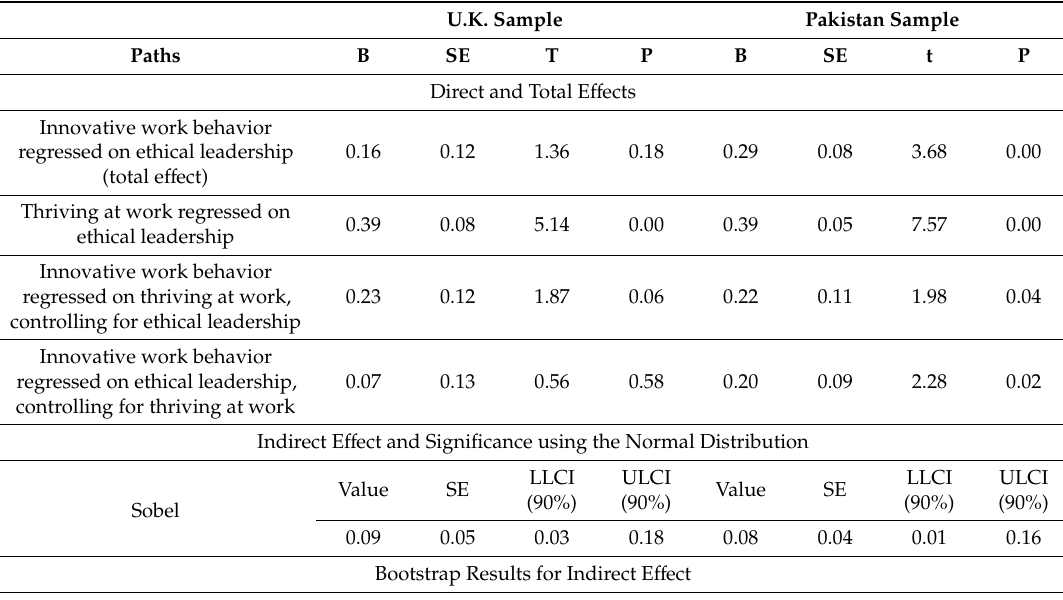
Table 4. Regression Results for Simple Mediation: Thriving at Work. U.K. Sample Pakistan Sample